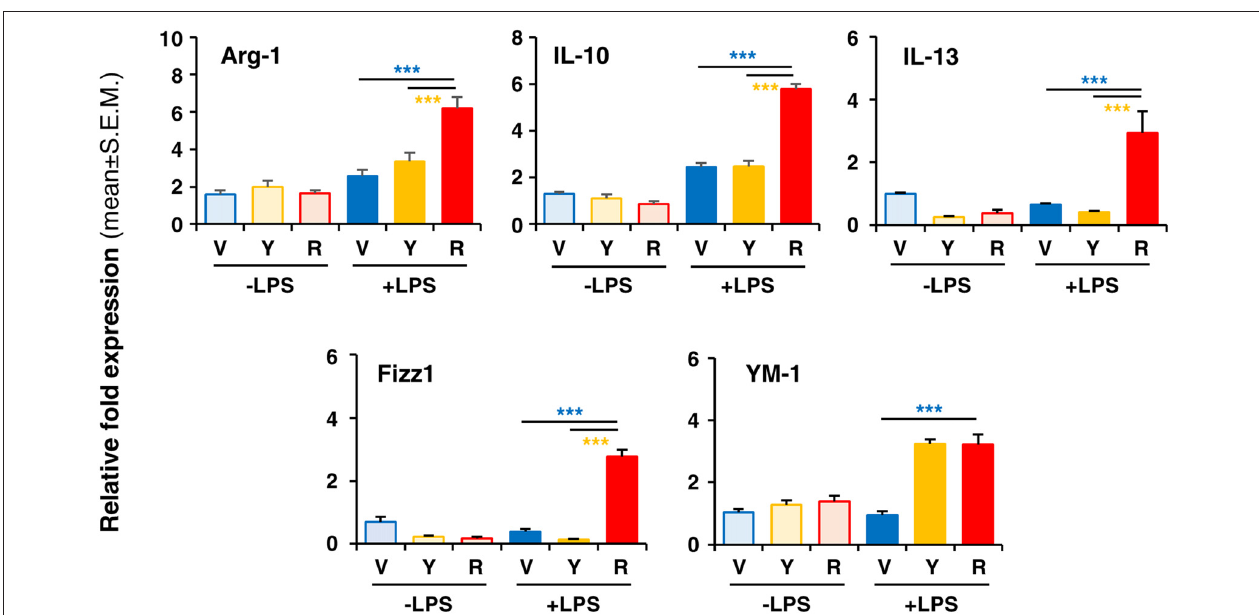
FIGURE 5 | In vitro treatment of LPS-activated rodent microglia with Red extract induces the expression of anti-inflammatory mediators. Rodent microglia cells were grown in culture, overnight exposed to medium alone, Yellow or Red extracts, and then challenged with medium alone or 1 µ g/ml LPS for 6 h (see “Materials and Methods” section for details). Cells were then collected, and the expression of anti-inflammatory genes was evaluated by Real time RT-PCR. Each transcript was normalized to corresponding control value (V, vehicle). Values shown are mean ± SEM from two independent experiments performed in triplicate. ∗∗∗ p < 0.001 with respect to cultures exposed to Red extract, one-way ANOVA followed by Bonferroni post hoc